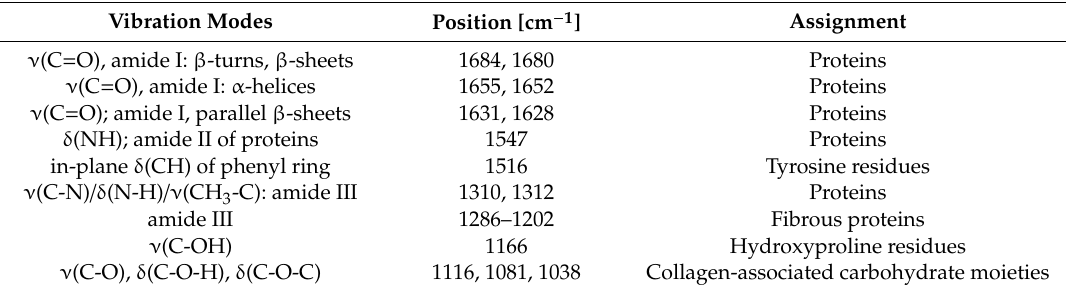
Table 2. An assignment of the major bands of Fourier transform infrared (FTIR) spectra depicted in Figure 2